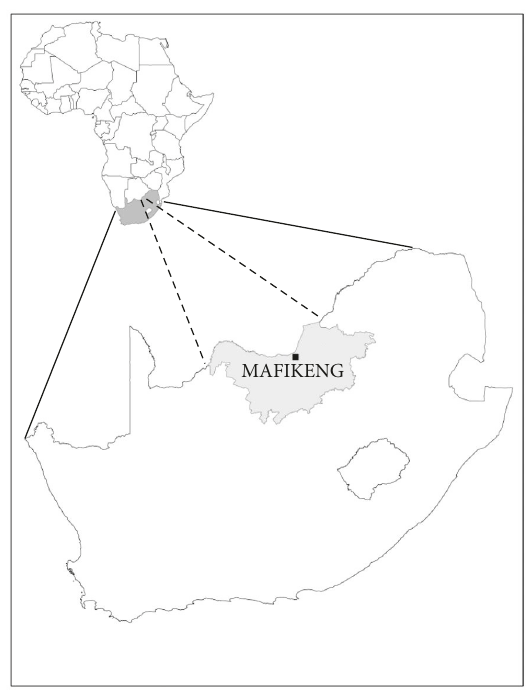
Figure 1: Map of Africa showing the Mafikeng sampling area in the North West Province of South